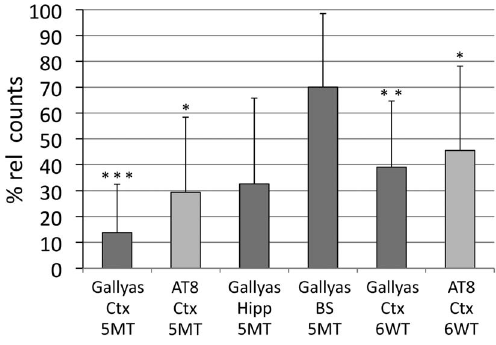
Figure 2. After long-term rapamycin treatment (n=6), unbi- ased stereology confirmed a significant reduction of cortical tau tangles to only 14% of the amount of tangles seen in vehicle treated (n=5) P301S mice (vehicle=100%). The number of AT8 stained cells containing hyperphosphorylated tau was reduced to 30% in aged rapamycin treated mice compared to controls (100%) (5MT group). A significant attenuation of Gallyas-stained (to 39% of controls) and AT8-positive cells (to 46% of controls) was also achieved by late short-term rapamycin treatment (6WT, n=6/6). The reduction of tangles in the hippocampus (to 33% of controls) and the brain stem (to 72% of controls) did not reach the level of significance adjusted for multiple testing. Pairwise reduction of Gallyas or AT8 positive counts was analysed using one-sample T-tests per brain region. Significant p- values, adjusted for the multiple comparisons of all 6 tested groups by the Holm-Bonferroni method, are outlined as follows: * p , 0.05, ** p , 0.01, and *** p , 0.001.